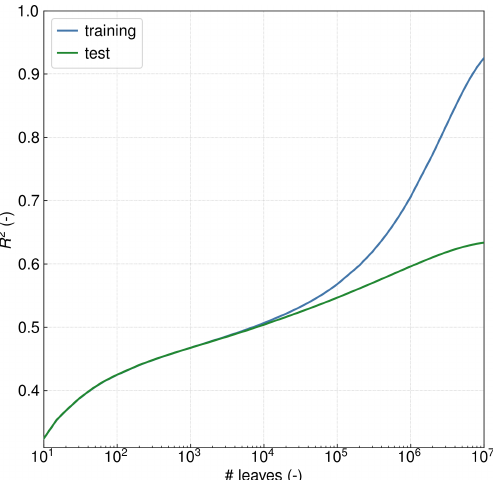
Figure 11. Coefficient of determination R 2 of the prediction as a function of the number of leaves of the decision trees in the random forest calibration. Since R 2 of the test dataset increases monotoni- cally with the number of leaves, there is no overfitting with regard to the depth of the decision trees in the random forest. The sweet spot of shallowness is considered to be the number of leaves at which the prediction score functions of training and test data begin to diverge, i.e. about 10000 leaves, which is used as the limit of tree growth in